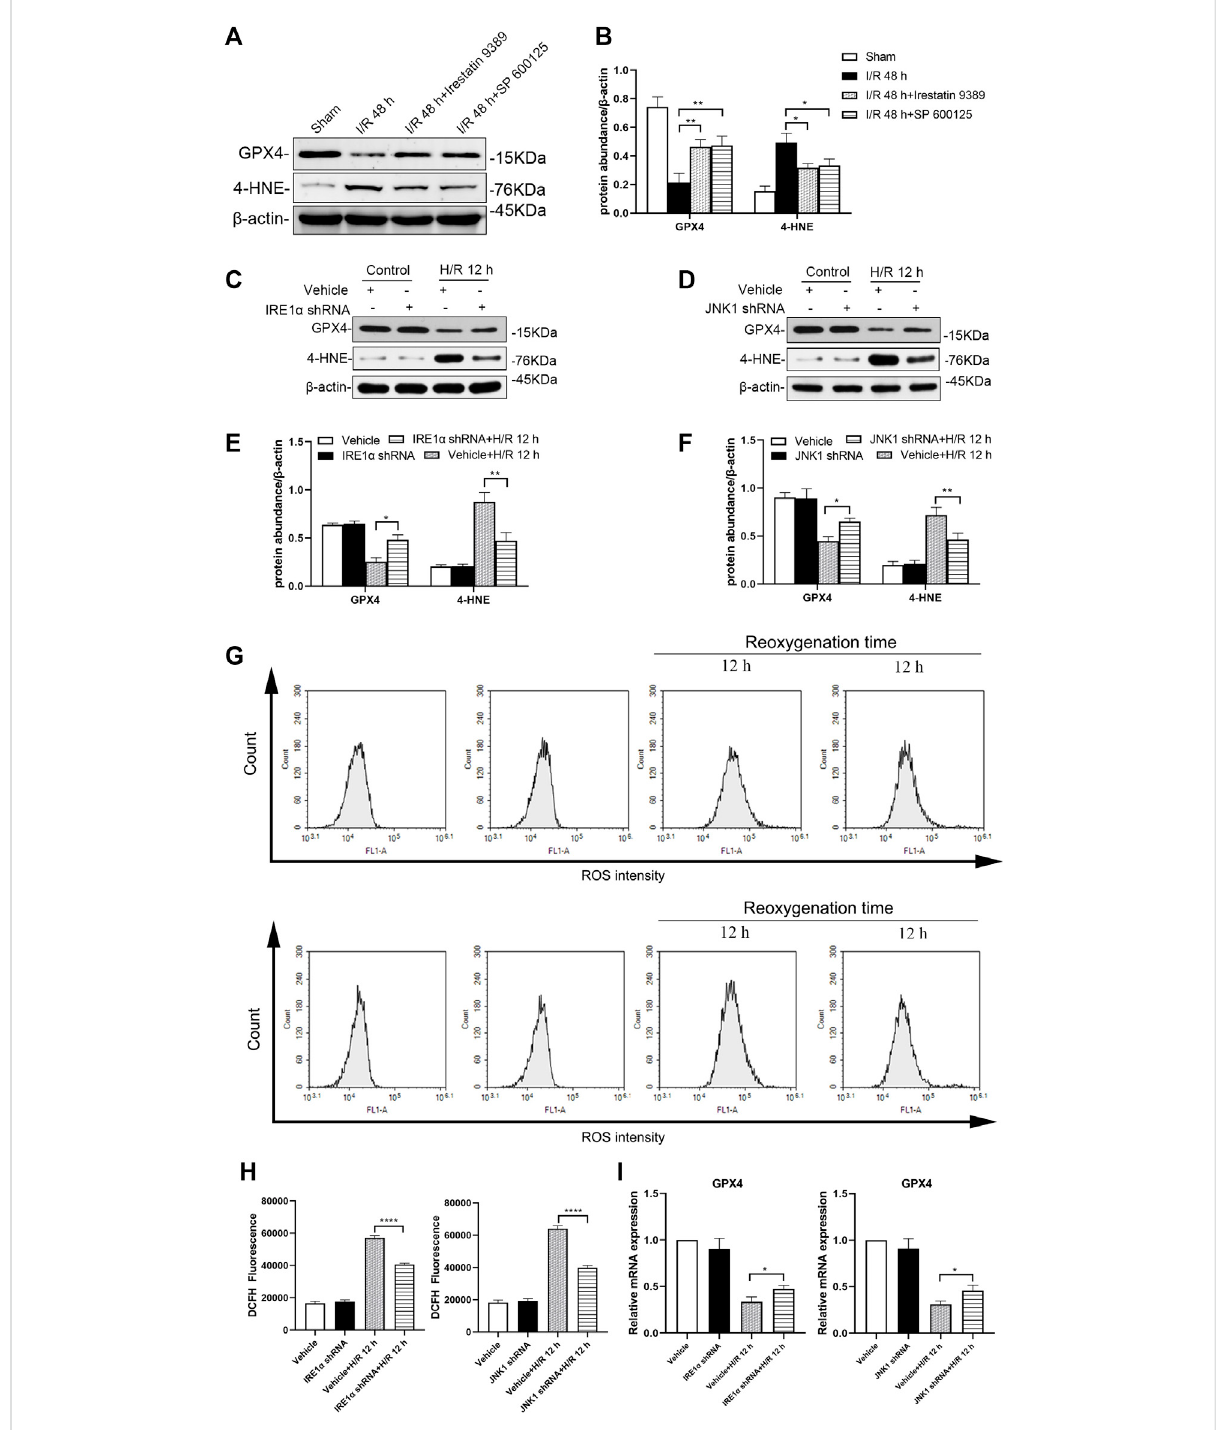
FIGURE 7 Depletion of IRE1 or JNK reduces ferroptosis in mice after I/R and HK-2 cells after H/R. Western blotting detection (A) and protein synthesis (B) ofGXP4 and4-HNE inrenaltissuesofmice at48 hafter I/R.Dueto thedeath ofmice, N= 5for each group. Western blottingwasused to detectthe expressionofGXP4and4-HNEinHK-2cellsdepletedofIRE1 α (C) orJNK (D) at12 hafterH/R, β -actinusedasaninternalcontrol.Proteinsynthesisof GXP4 and 4-HNE in western blotting in HK-2 cells depleted of IRE1 α (E) or JNK (F) at 12 h after H/R (G) Flow cytometry detection of ROS produced by HK-2 cells treated with shRNA IRE1 α or shRNA JNK1 (H) Analysis of ROS in fl ow cytometry in HK-2 cells at 12 h after H/R (I) mRNA expression ofGXP4inHK-2cells treatedwithshRNA IRE1 α orshRNAJNK1 detectedbyqRT-PCR.Statisticalsigni fi cance isdenoted as*: p < 0.05, **: p < 0.01, ****: p < 0.0001 in two